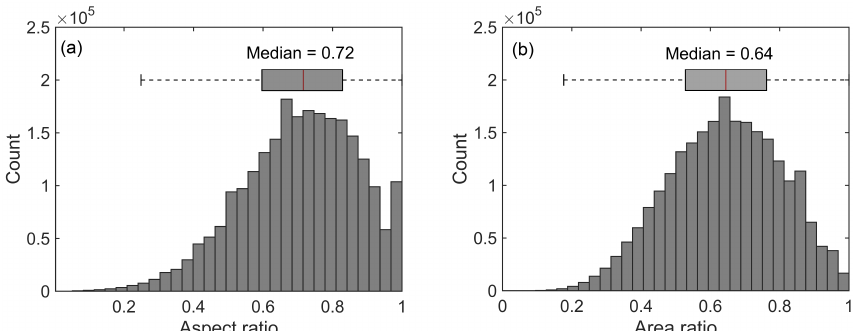
Figure 3. The distributions of snowflake (a) aspect ratio and (b) area ratio as observed using PIP with interquartile ranges visualized and median values